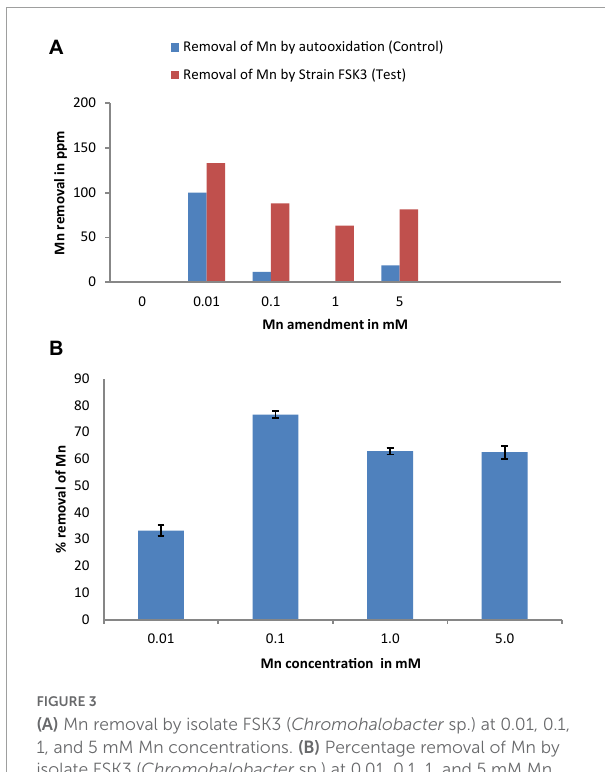
FIGURE3 (A) Mn removal by isolate FSK3 ( Chromohalobacter sp.) at 0.01, 0.1, 1, and 5 mM Mn concentrations. (B) Percentage removal of Mn by isolate FSK3 ( Chromohalobacter sp.) at 0.01, 0.1, 1, and 5 mM Mn